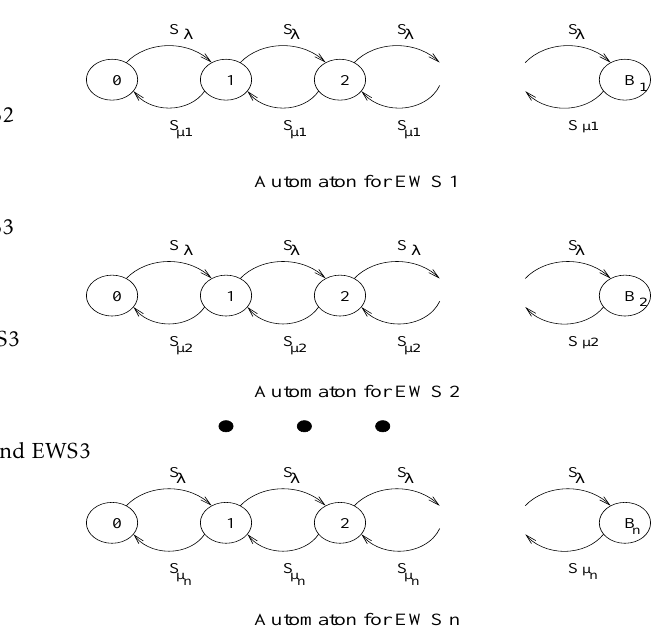
Figure 3. stochastic Automata for elementary service